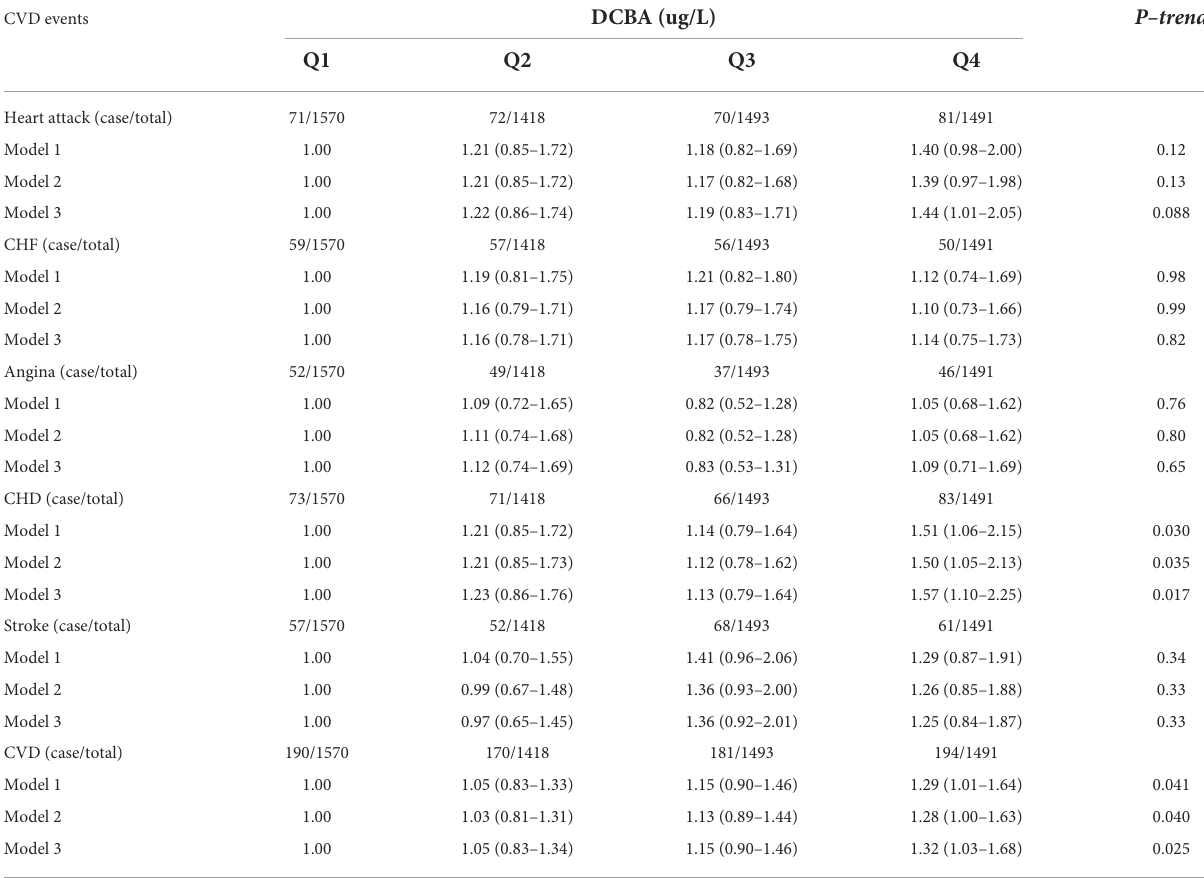
TABLE 4 Associations of urinary DCBA with total and specific CVD in